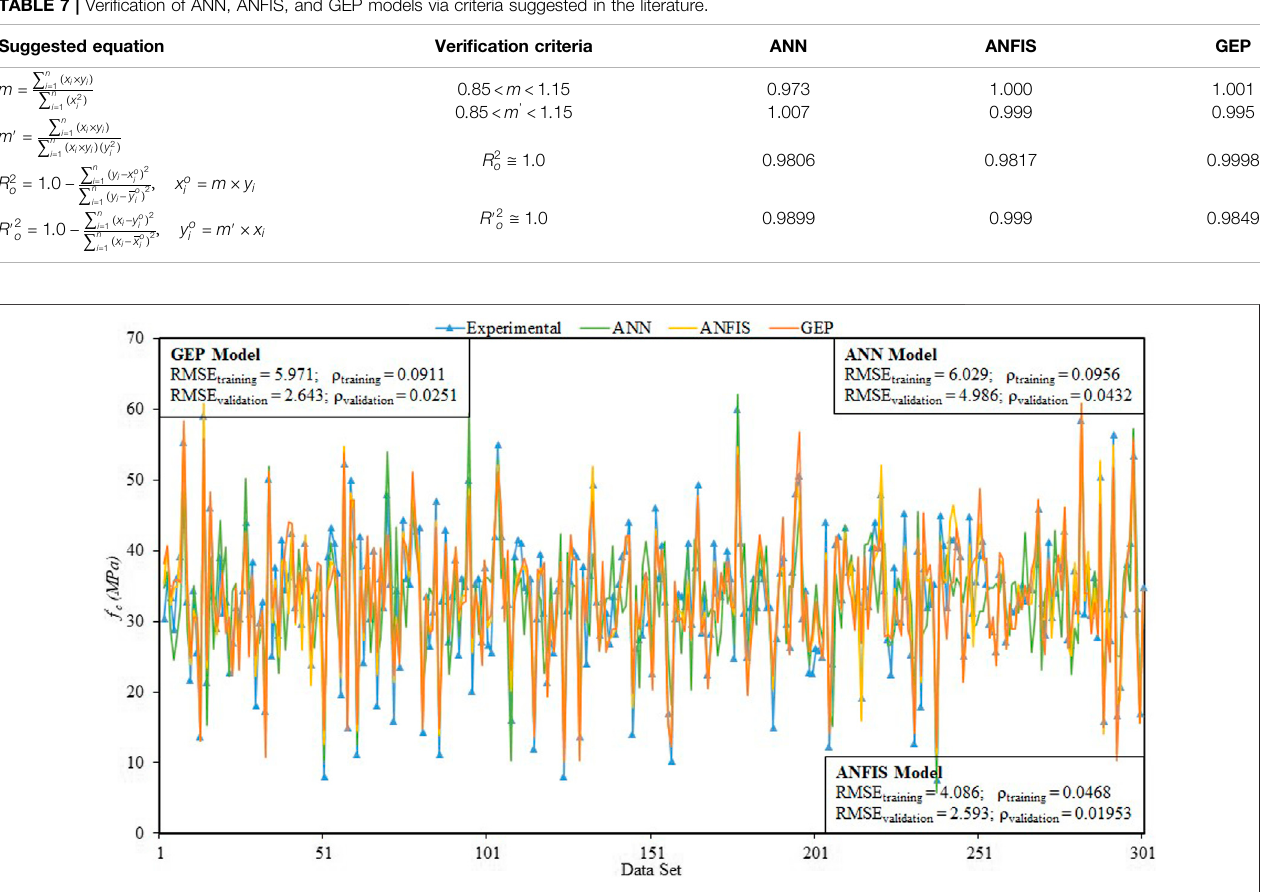
FIGURE 9 | Comparison between the predicted compressive strength via ANN, ANFIS, and GEP models.